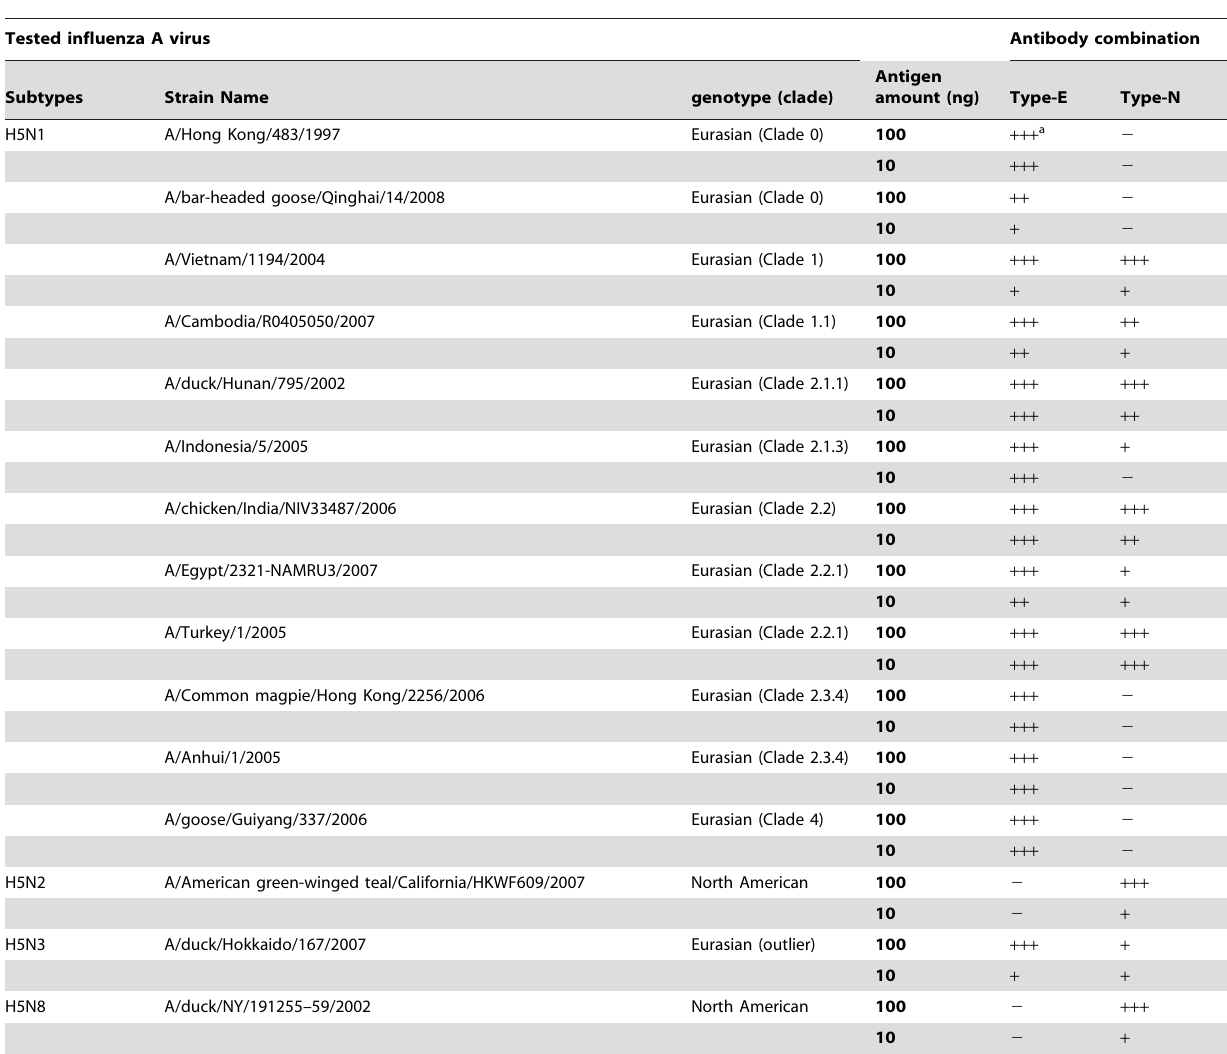
Table 2. Specificities of colloidal gold IC for H5 subtypes of recombinant HA protein.